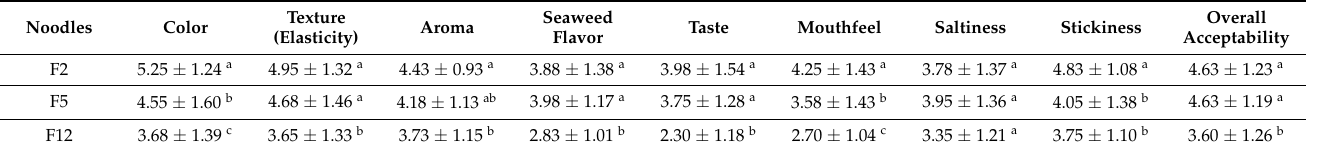
Table 2. Sensory data for noodles samples F2, F5, and F12.